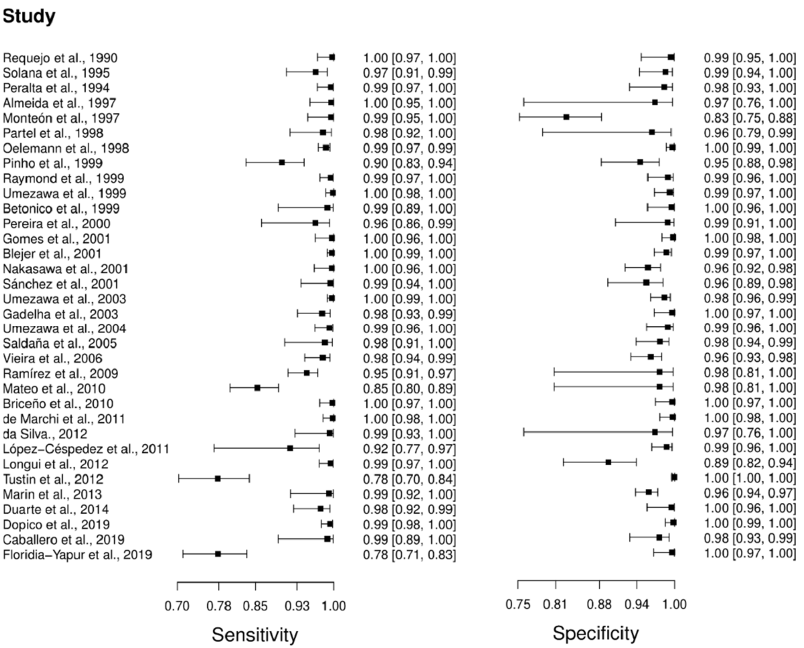
Figure 4. Study data and paired forest plot of the sensitivity and specificity of Enzyme-linked immunosorbent assay (ELISA) in Chagas’s disease diagnosis. Data from each study are summarized. Sensitivity and specificity are reported with a mean (95% confidence limits). The Forest plot depicts the estimated sensitivity and specificity (black squares) and its 95% confidence limits (horizontal black line) [46–79].